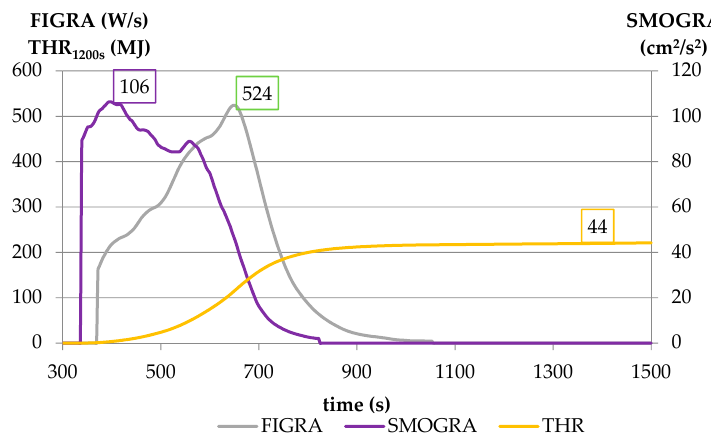
Figure 9. Heat release and smoke production results for PVC-insulated and sheathed coaxial cable.